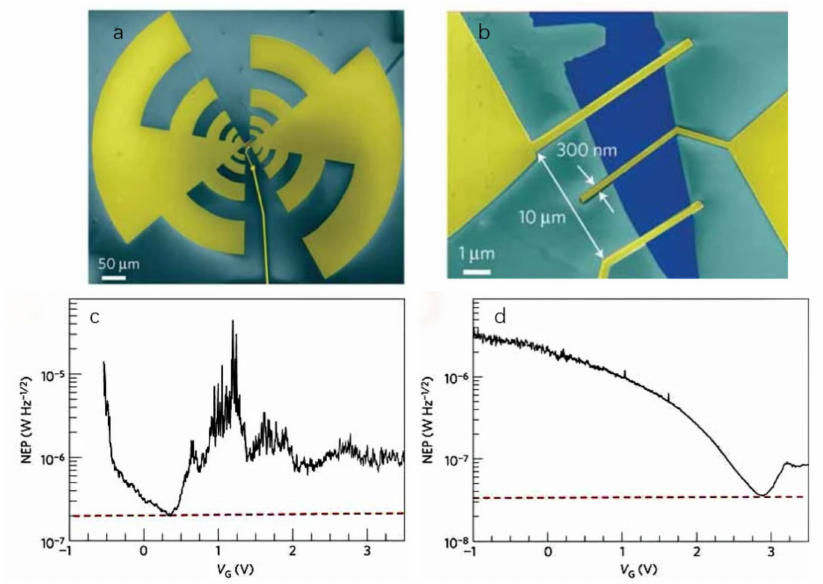
Figure 10. ( a ) The model of the fabricated detector. ( b ) The channel length is 10 µ m, with a gate width 300 nm. ( c ) The curve of NEP with single-layer graphene, and ( d ) The bilayer graphene in which the dotted line indicates the minimum value. Reprinted with permission from ref. [122]. Copyright 2021 Copyright Clearance